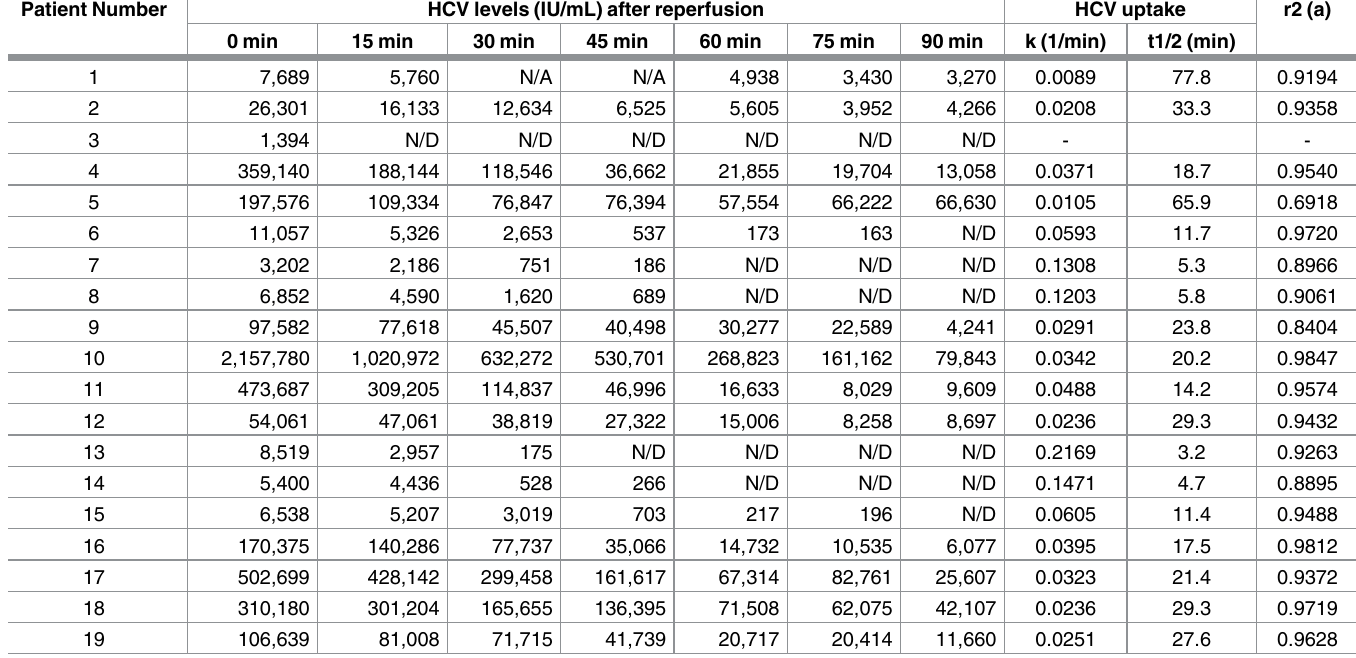
Table 2. HCV clearanceduring initial allograft reperfusion. All HCV levels were normalized to internalcontrol. Internal control was detectablefor all sam- ples. Measuresof HCV clearancewere: k (rate constant) and t 1/2 (half-life). (a) r 2 was determinedfrom the natural log of HCV viral load over time. N/A: sample not available. N/D: none